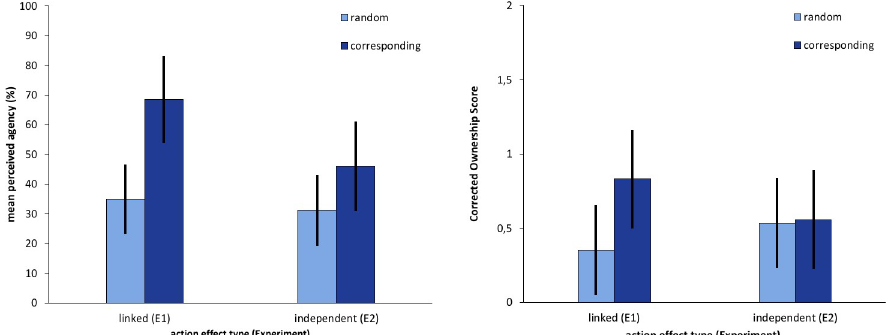
Fig 5. Mean reported agency and corrected ownership scores of Experiment 1 (E1) and 2 (E2). Error bars represent 95% between-subject CIs.